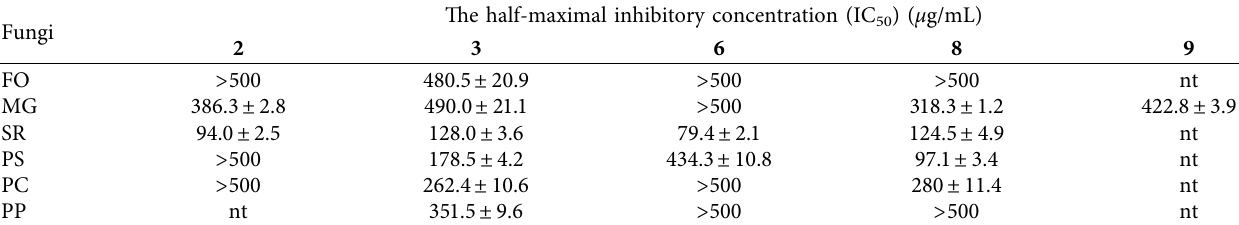
Table 2: The half-maximal inhibitory concentration (IC 50 , µ g/mL) of limonoids 2 , 3 , 6 , 8 , and 9 against the mycelial growth of phy- topathogenic fungi and oomycetes in vitro .